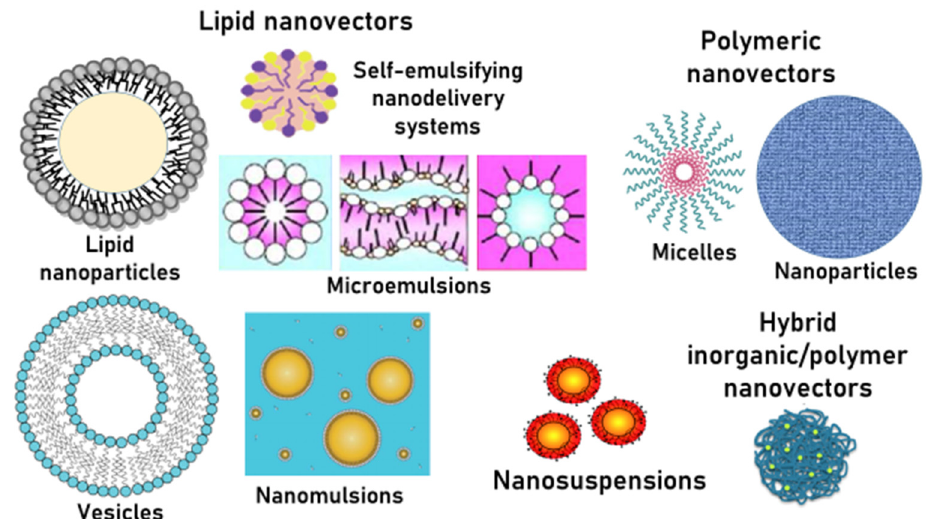
Figure 3. Nanosuspensions and polymeric, lipid-based, and hybrid nanocarriers.